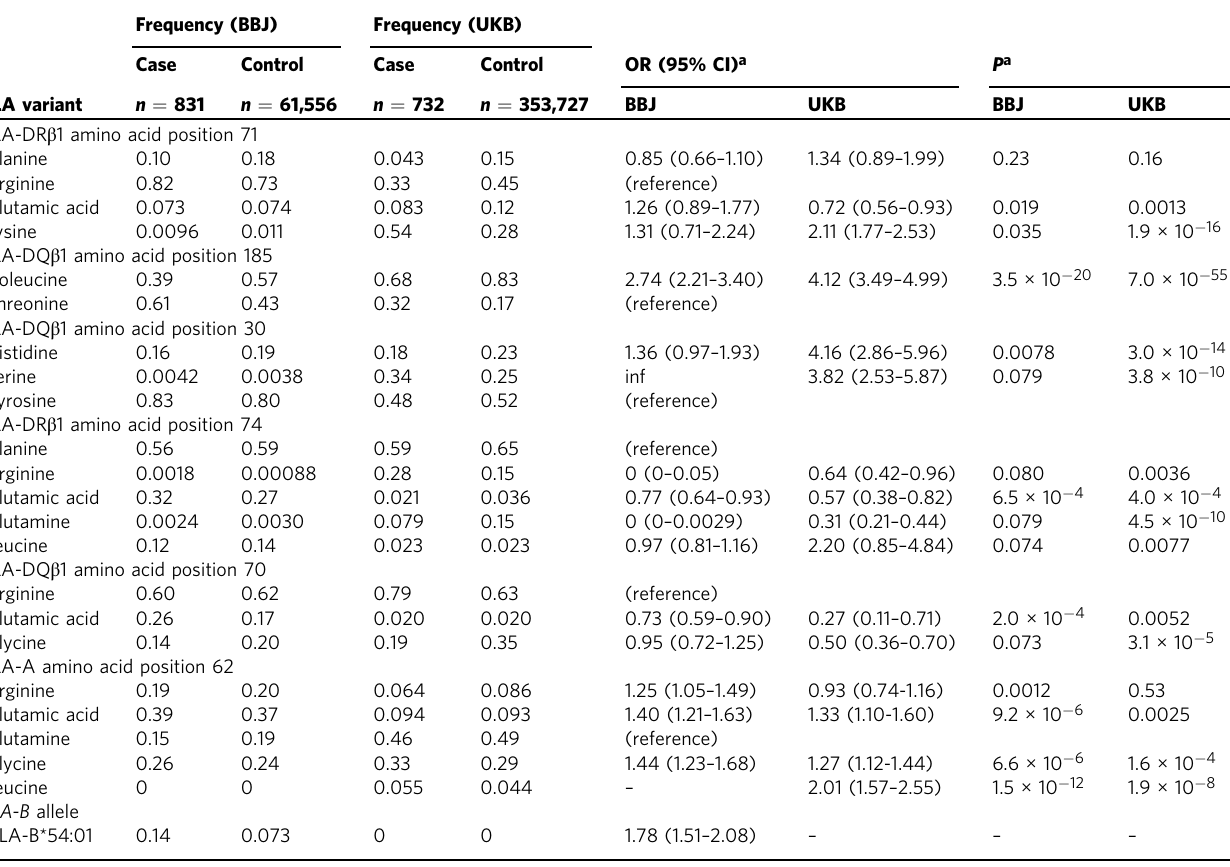
Table 1 Associations of the HLA variants with the T1D risk identi fi ed through trans-ethnic fi ne-mapping